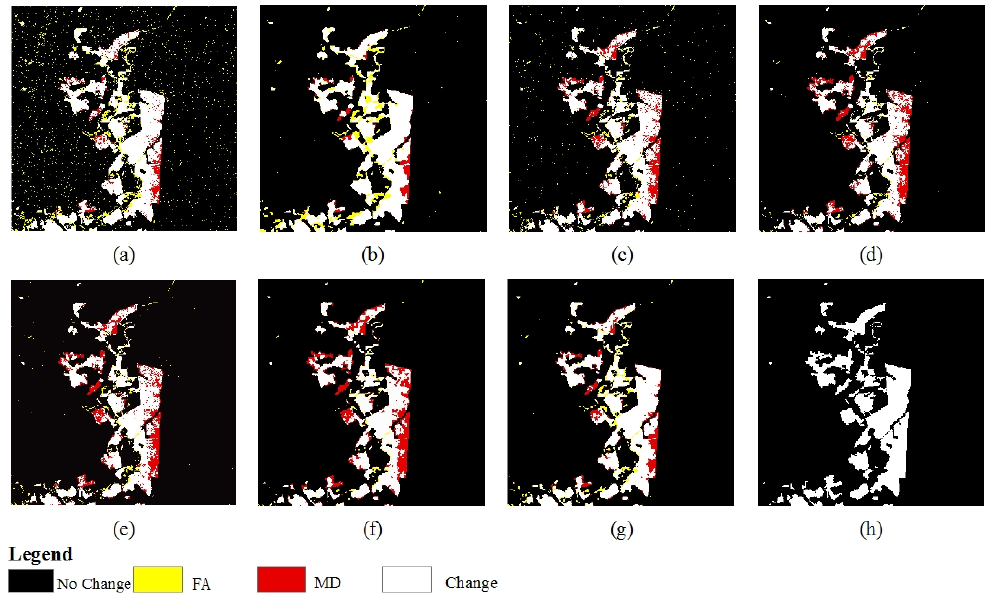
Figure 11. Final change detection maps of the Madeirinha dataset produced by ( a ) EM; ( b ) EMMRF; ( c ) FCM; ( d ) FLICM; ( e ) RFLICM; ( f ) sRSFCM; ( g ) proposed RSFCM; and ( h ) reference